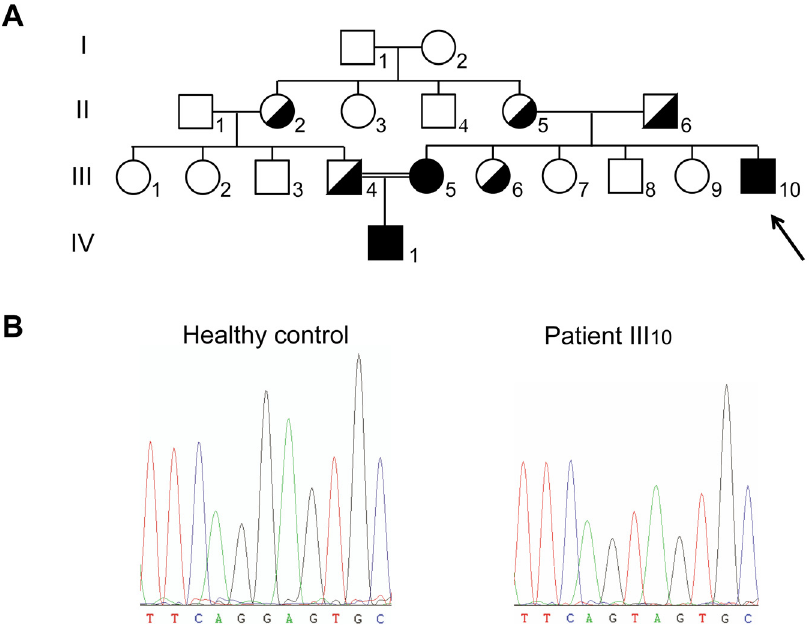
Figure 1. Pedigree and genotype of the patients. (A) Family pedigree. Identified carriers are indicated in half blackened symbols and CF patients in blackened symbols. Consanguinity between individuals III 4 and III 5 is highlighted with a double line. (B) Sequence analysis performed on the genomic DNA from a healthy control and patient III 10 .